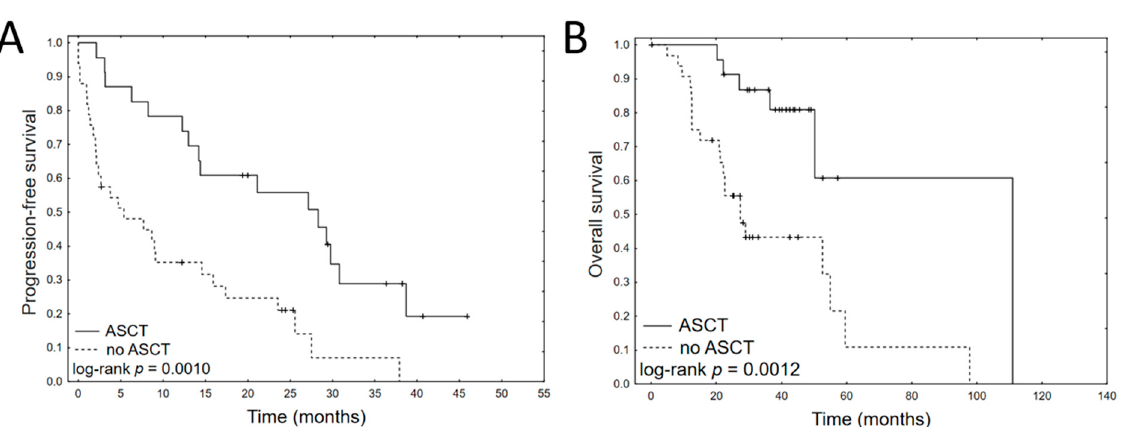
Figure 1. Kaplan–Meier plots of progression-free survival ( A ) and overall survival ( B ) for ASCT in MM patients treated with